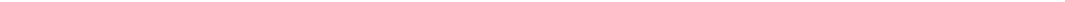
Figure 1: S. sonnei chromosome phylogeny and presence of key plasmids. The phylogenetic analysis was performed in CLC Genomics Workbench v. 9.5.3, mapping against reference strain Ss046 chromosome (accession number CP000038), variants called at 10 × minimum coverage, 10 minimum count and 70% minimum frequency. SNP tree generation used the following parameters: minimum coverage = 10, min- imum coverage % = 10, minimum z-score = 1.96, MNVs (multinucleotide variants) included, and used a neighbour-joining method. Lineage